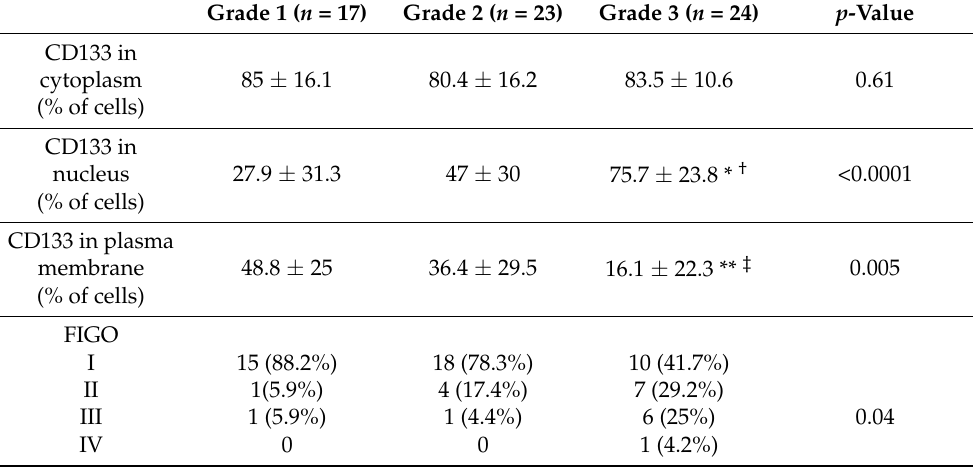
Table 2. Cellular localization of CD133 is associated with endometrial cancer grading.